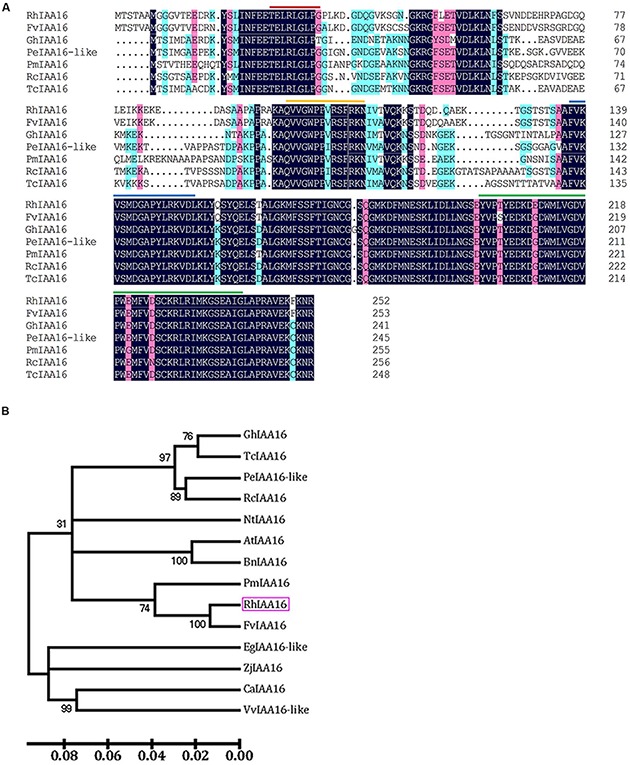
Alignment of deduced amino acid sequences (A) and phylogenetic tree (B) of RhIAA16 protein and representative Aux/IAA members. Lines indicated representatively conserved motif, including red line, domain I; yellow line, domain II; blue line, domain III; green line, domain IV (Audran-Delalande et al., 2012).